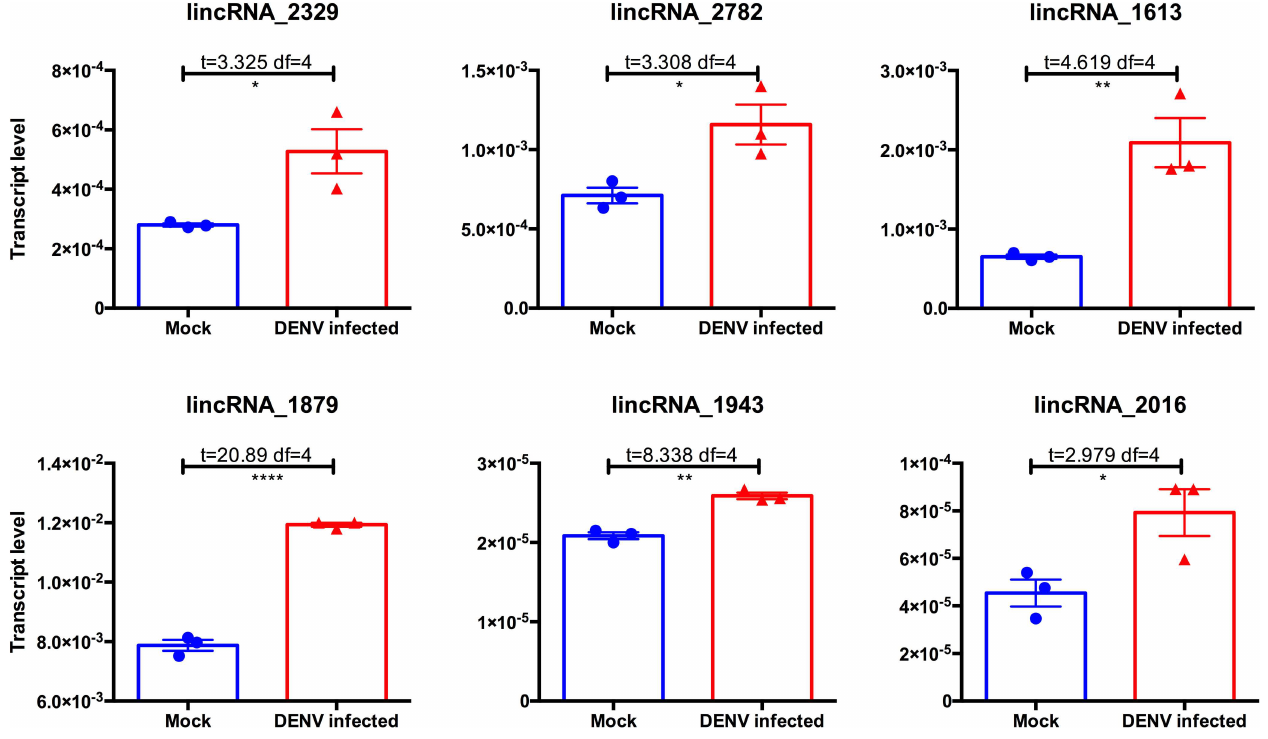
Fig 5. DENV infection leads to changes in the abundance of Ae . aegypti lincRNAs. The relative transcript levels of selected numbers of Ae . aegypti lincRNAs were measured by RT-qPCR analysis of Aa20 cells infected with 1 MOI of DENV-2 for three days. Three biologicalreplicates were used for each treatment with three technicalreplicates each. * , p < 0.05; ** , p < 0.01; **** , p <